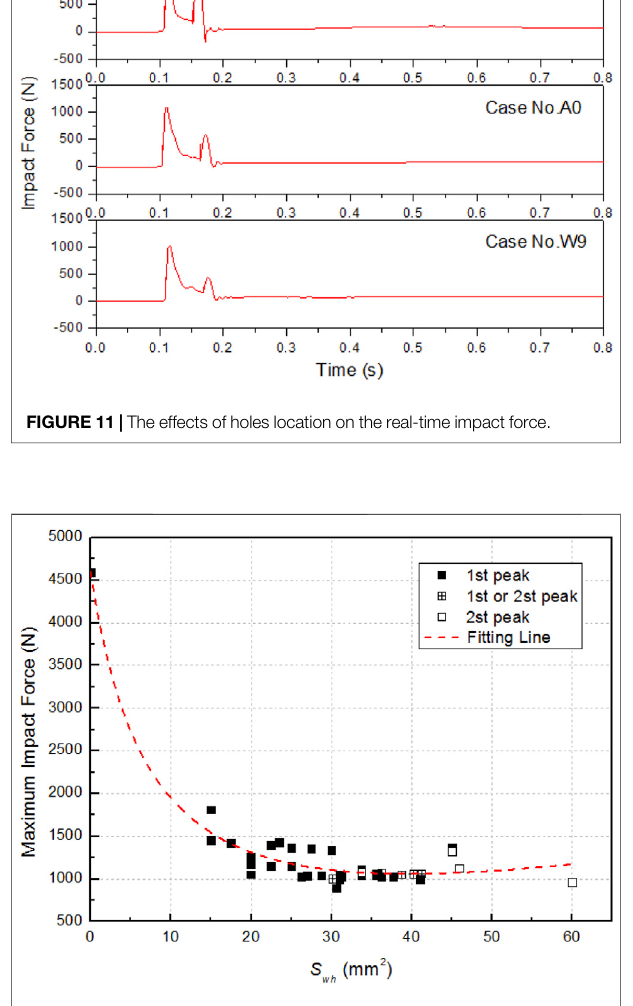
FIGURE 12 | The relationship between the maximum impact force and the equivalent ongoing fl ow area of the drain holes.